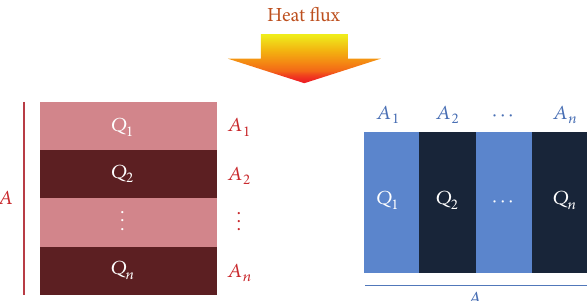
Figure 1: Critical boundaries of thermal conductivity in composite